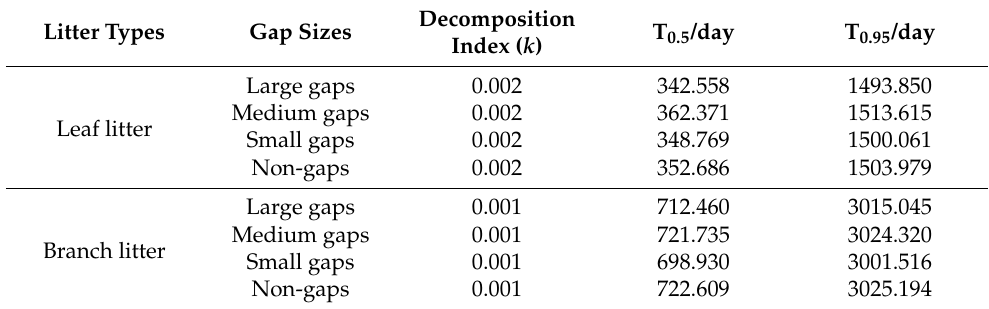
Table 2. Regression equation of litter mass remaining during litter decomposition.